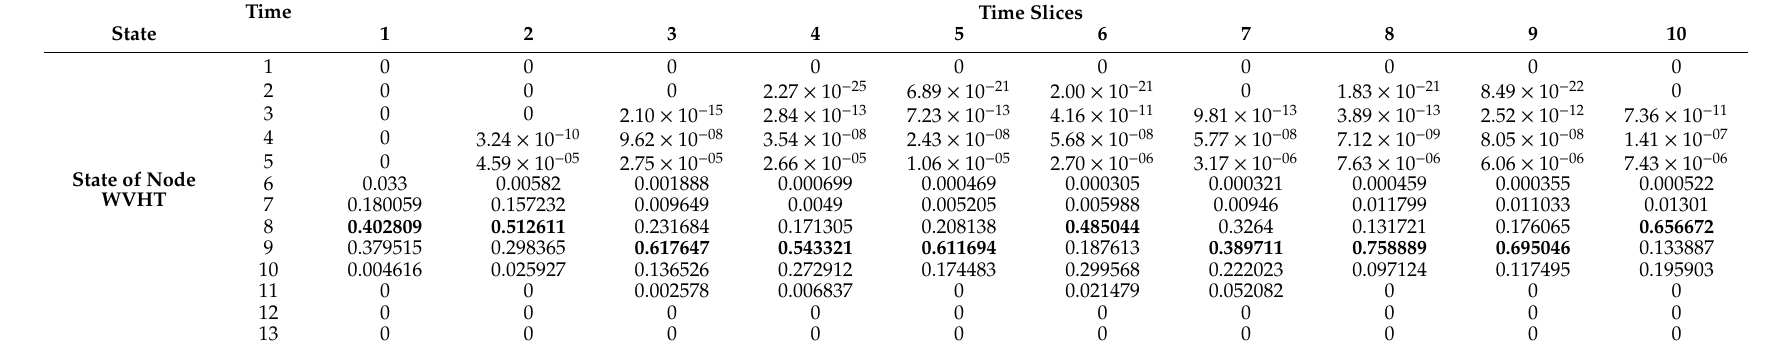
Table A1. The posterior probability distributions of WVHT. The boldface font indicates the maximal